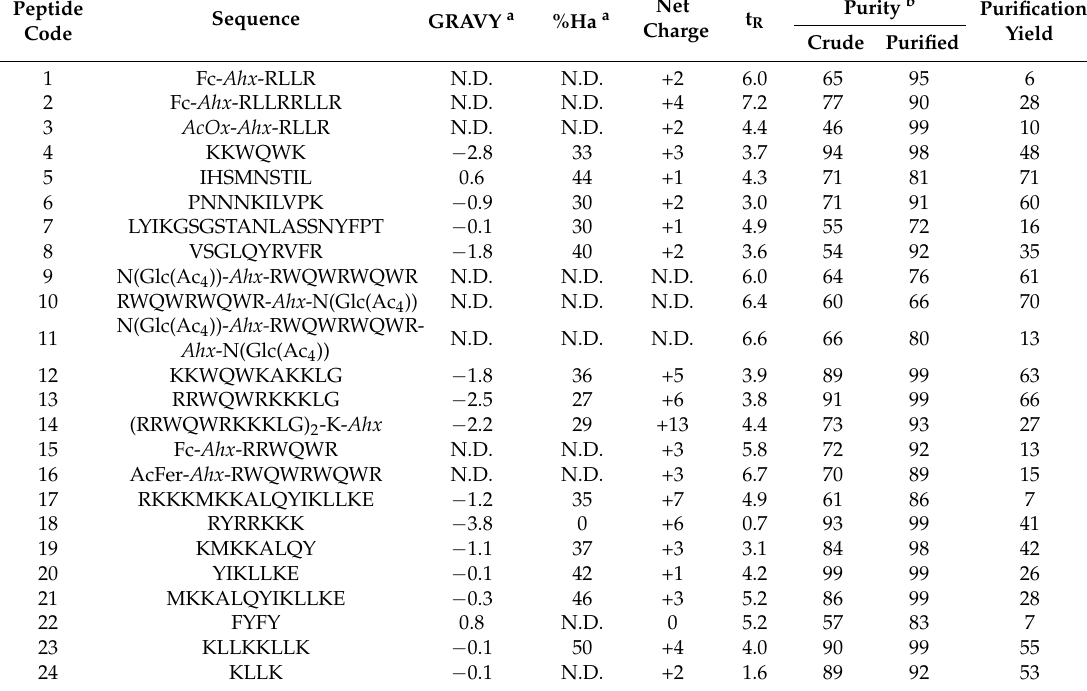
Table 2. Peptides purified by